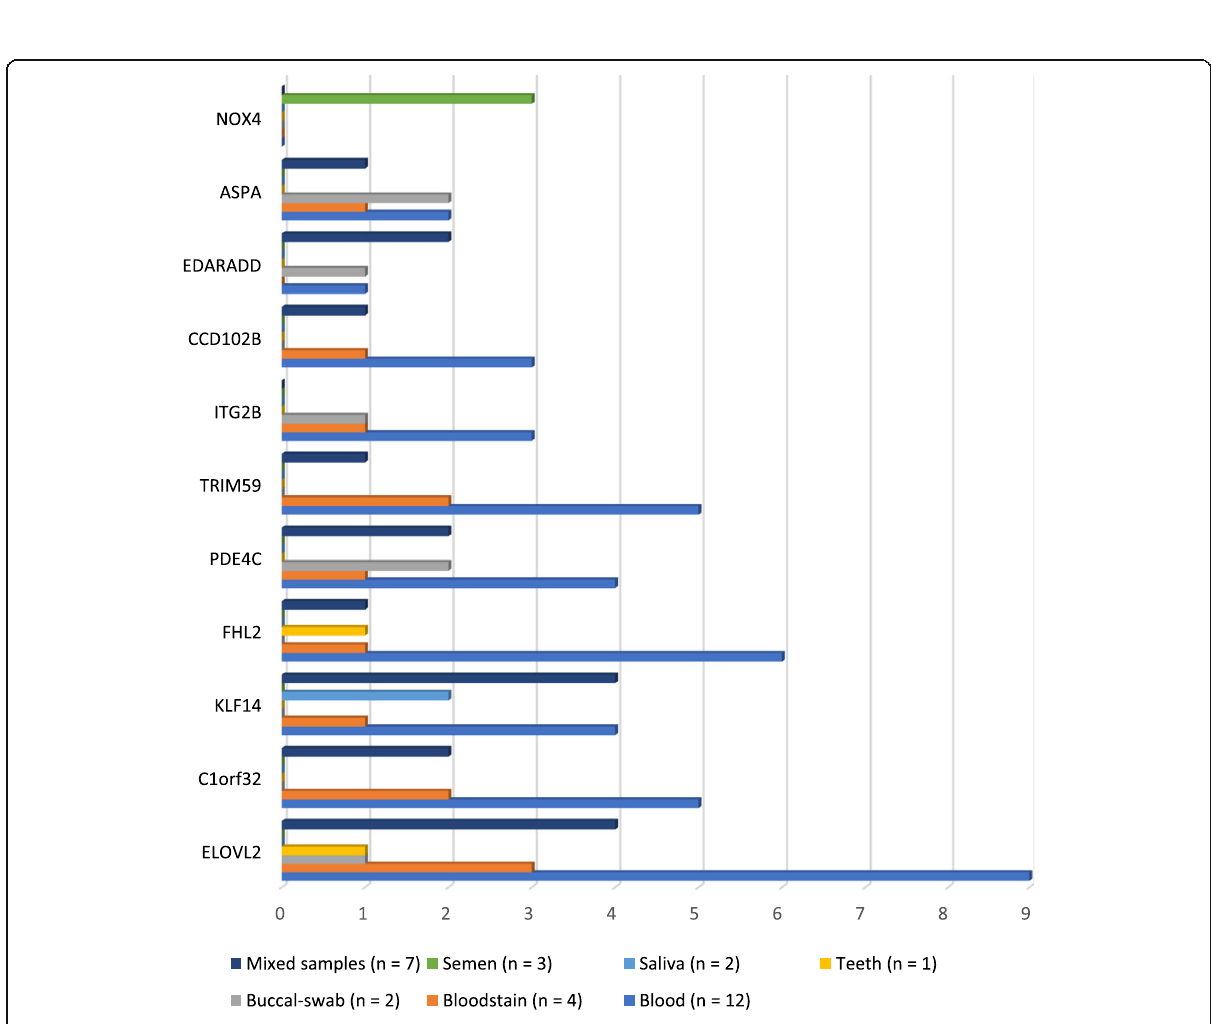
Fig. 7 The genes mostly used in the studies